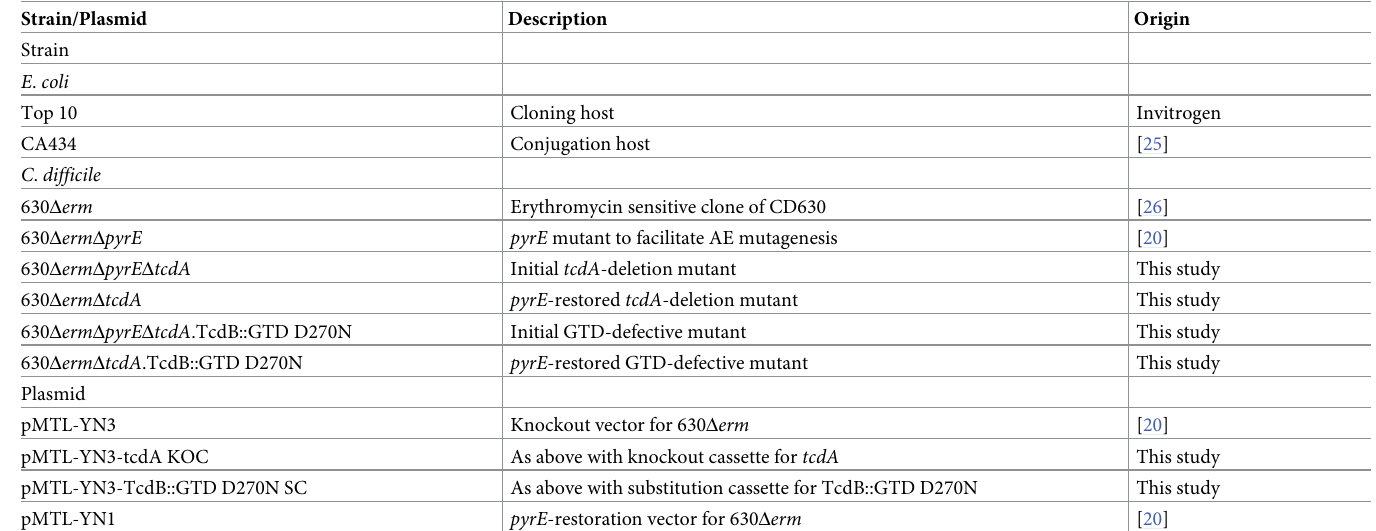
Table 1. Strains used in this